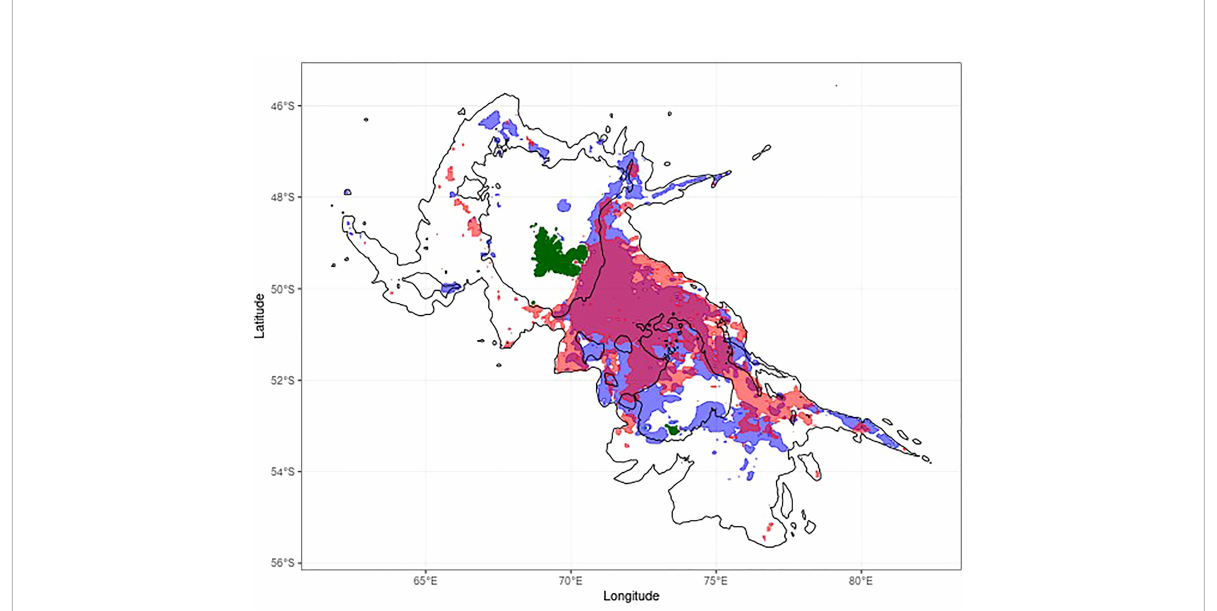
FIGURE 4 Comparison of 90% utilization distributions of post-molt males (blue) and female (red) elephant seals tagged at Iles Kerguelen. The contours represent the -500 and -2000 m